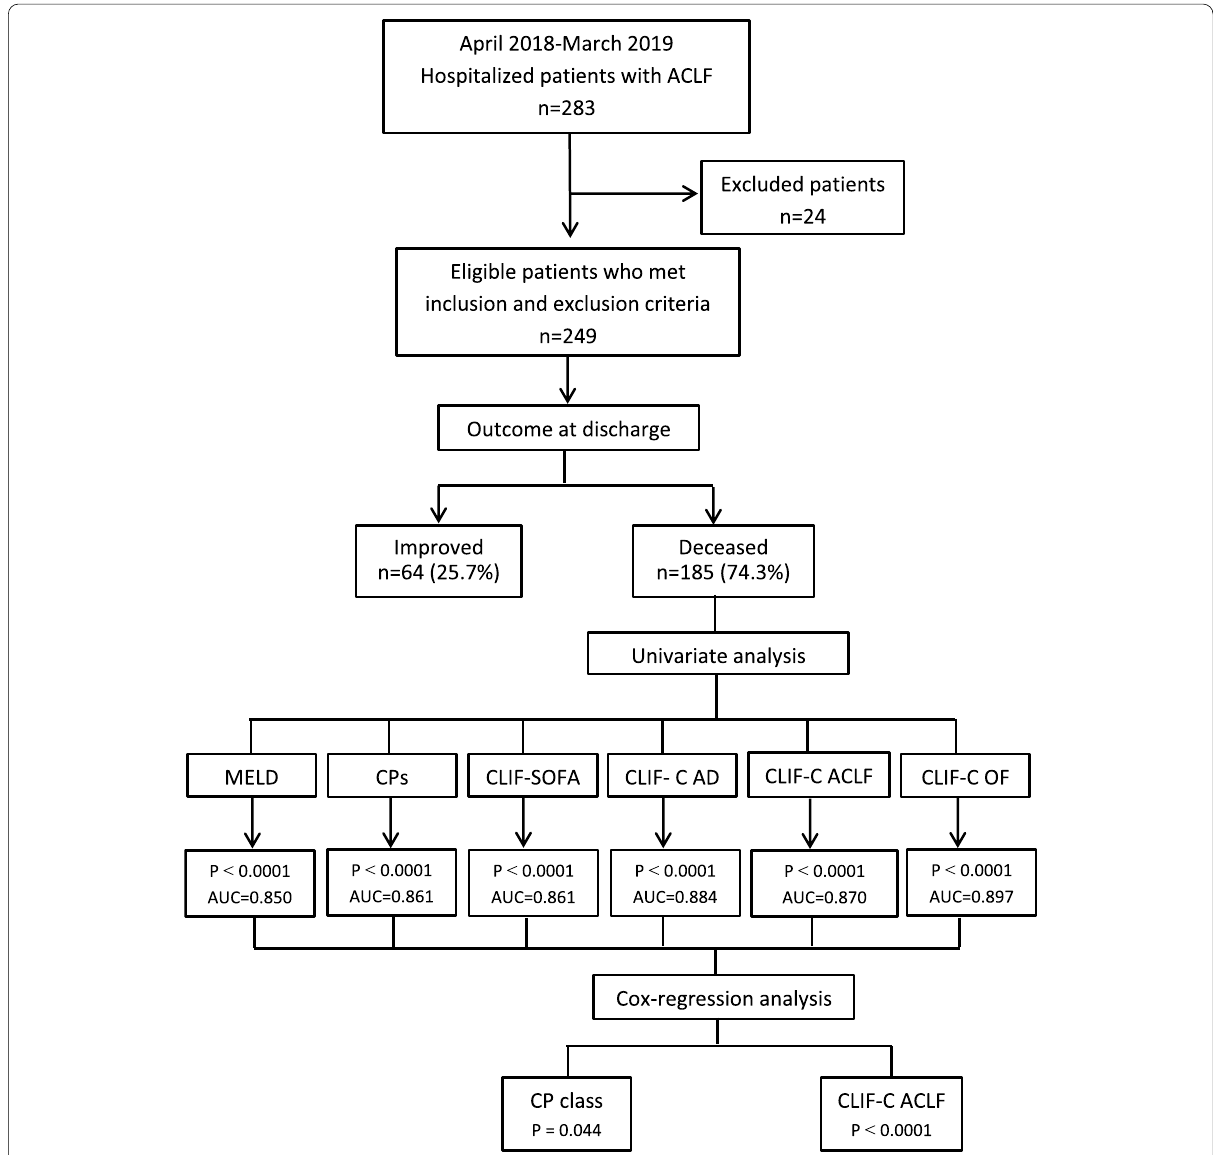
Fig. 1 Flow diagram of the study. Legend: ACLF, acute‑on‑chronic liver failure; AD, acute decompensation; AUC, area under the ROC curve; CLIF‑C, chronic liver failure consortium; CP, Child‑Pugh; MELD, model for end‑stage liver disease; OF, organ failure; SOFA, Sequential Organ Failure